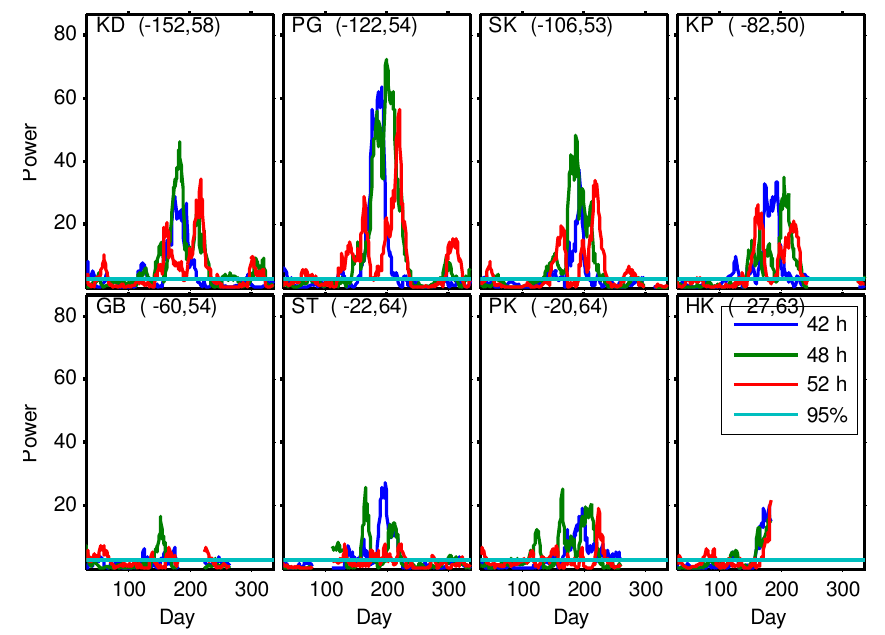
Figure 3. The normalised power spectrun of the zonal 42-, 48- and 52-h QTDW Fig. 3. The normalised power spectrum of the zonal 42-, 48- and 52-h QTDW components for different radars, as indicated by the abbrevia- components for different radars, as indicated by the abbreviations on the top left-hand tions on the top left-hand corner of each panel. The horizontal line represents the 95% confidence level. corner of each panel. The horizontal line represents the 95% confidence level. MERIDIONAL FLOW: Normalised power spectrum (28d window)